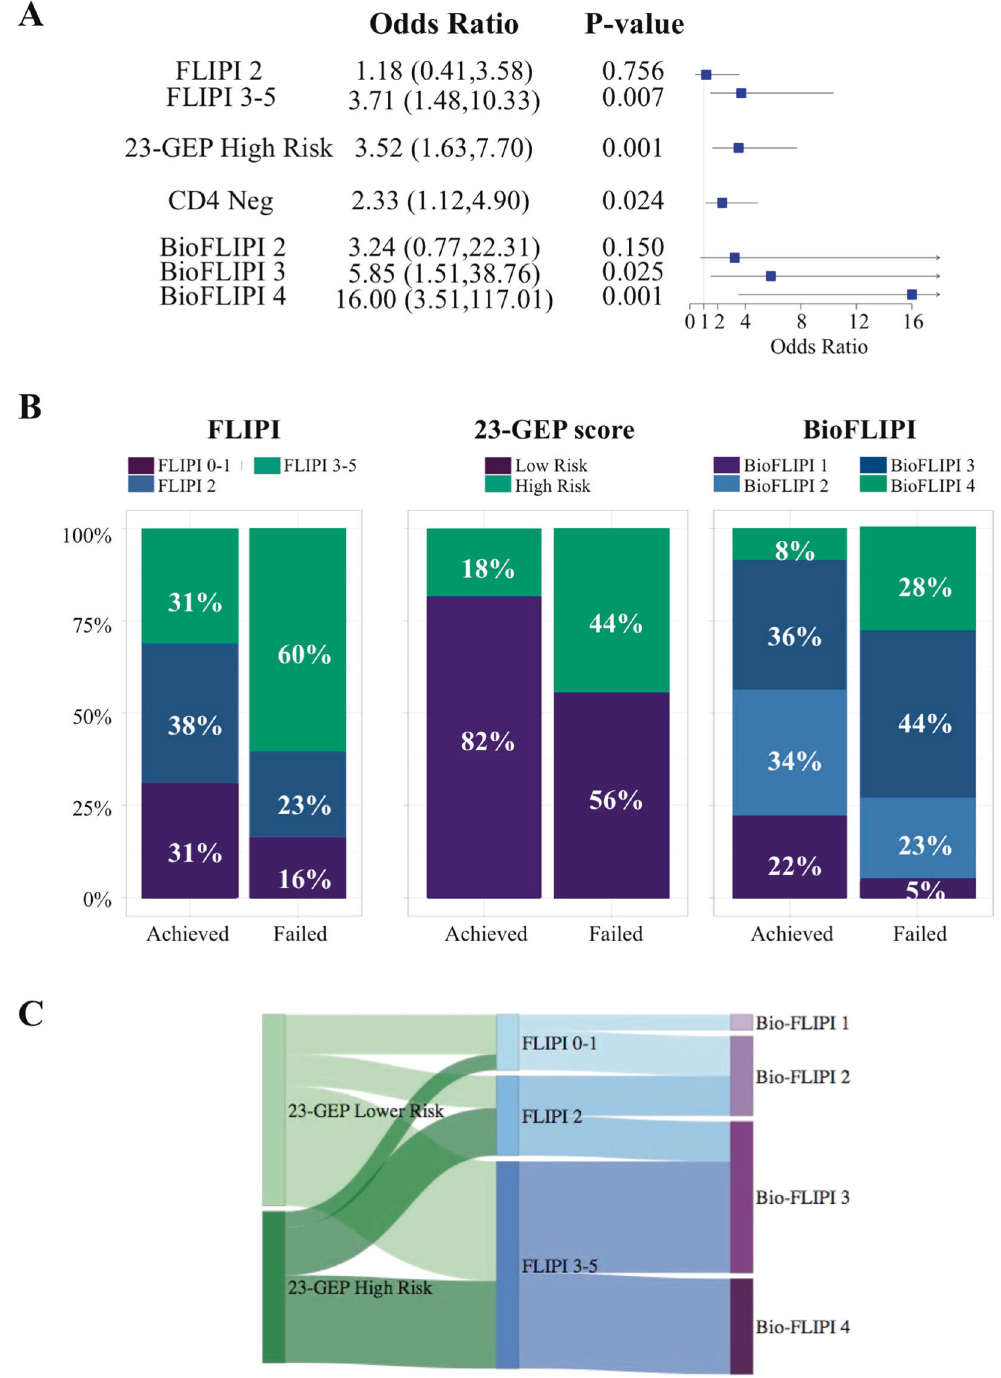
Fig. 6 Intrafollicular CD4 + expression and tumor gene expression pro fi le are independent prognostic factors in follicular lymphoma. A Forest plots showing the association between FLIPI, 23-GEP, and CD4 + expression and BioFLIPI risk groups and early failure. B Bar graph showing the percentages of 152 follicular lymphoma patients treated with immunochemotherapy who achieved or not event-free survival at 24 months in the indicated risk groups of FLIPI, 23-GEP, and BioFLIPI risk models. C Distribution of the follicular lymphoma patients from ( B ) who failed EFS24 ( n = 43) from the FLIPI subgroups (center) within the 23-GEP (left) and BioFLIPI (right) risk